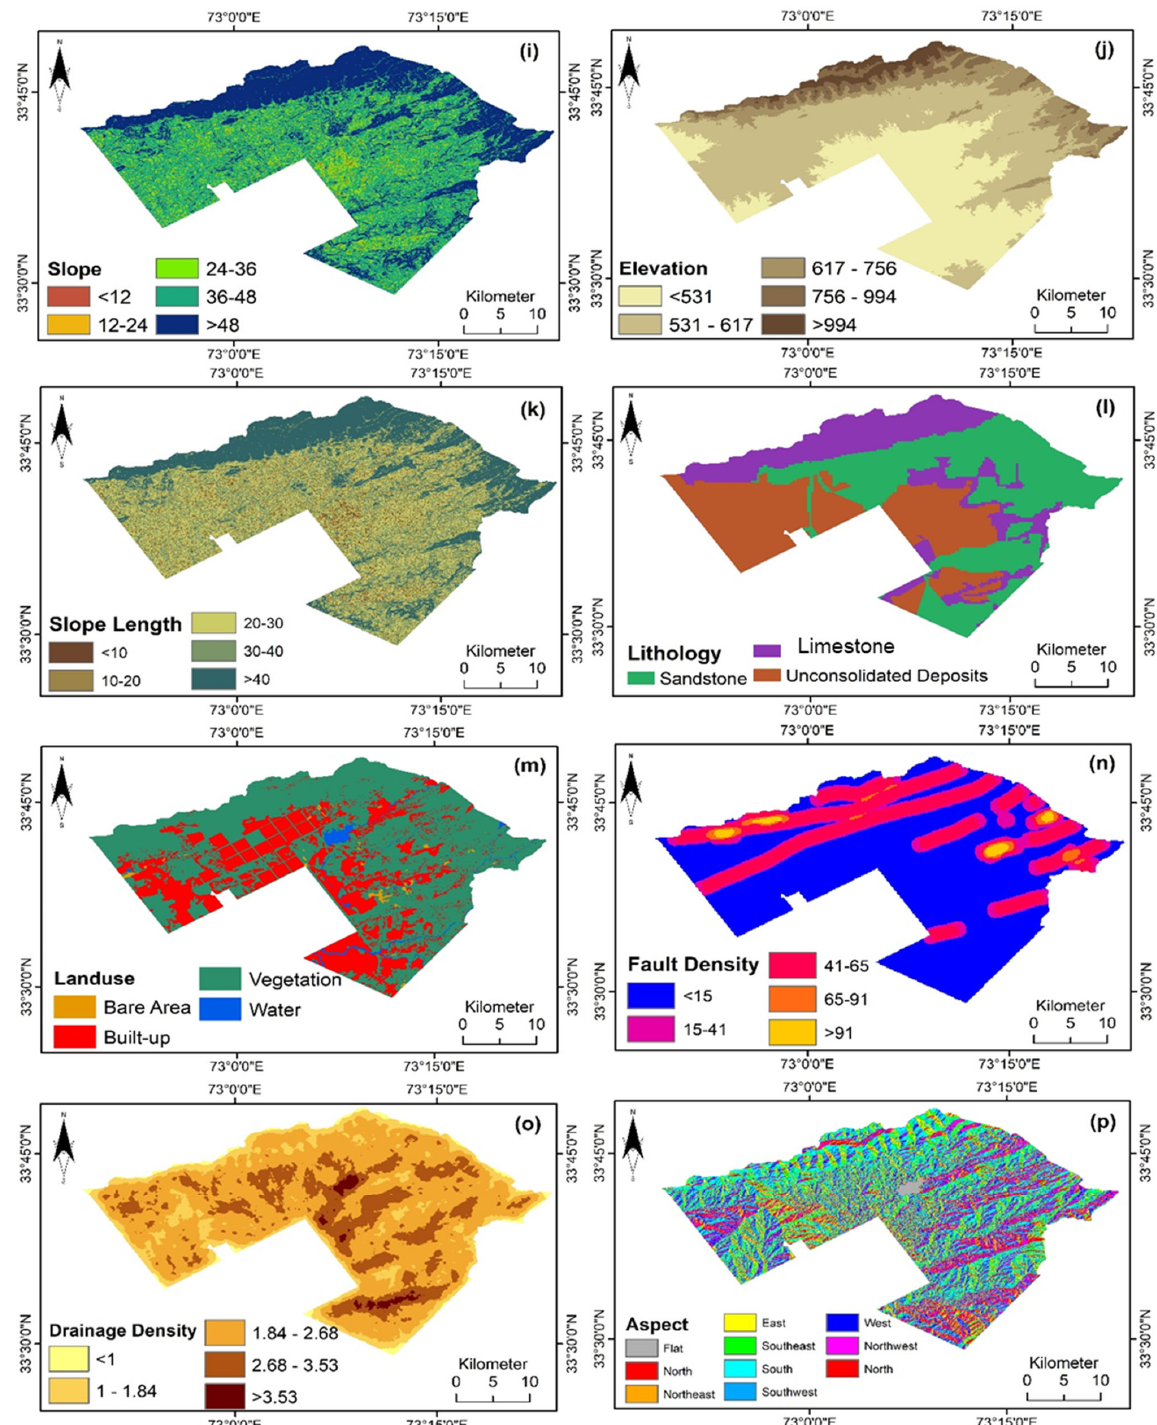
Figure 3. Thematic layers of selected factors for Islamabad’s data (part 1), ( a ) well data, ( b ) rainfall data, ( c ) plan curvature, ( d ) soil data, ( e ) distance to fault, ( f ) drainage distance, ( g ) profile curvature, ( h ) TWI, ( i ) slope, ( j ) elevation, ( k ) slope length, ( l ) lithology, ( m ) land use, ( n ) fault density, ( o ) drainage density, ( p ) aspect.